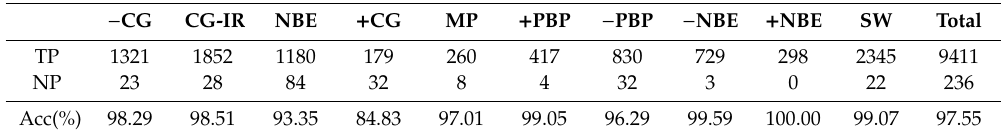
Table 3. The classification accuracy of the model on the test